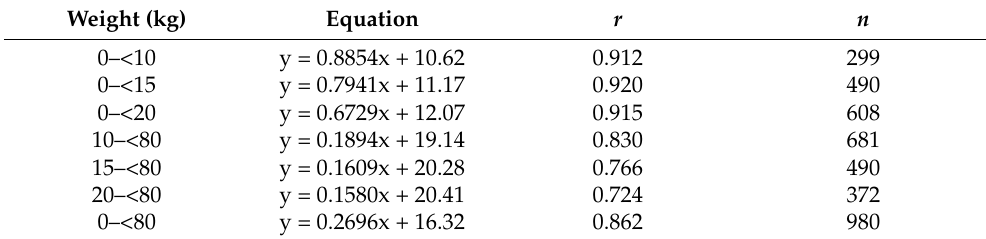
Figure 3. Linear regression analysis of CTDIvol and weight for < 20 kg ( a ) and ≥ 10 kg ( b ). In panel ( a ), the blue, red, and green plots represent data of 0–<10, 10–<15, and 15–<20 kg, respectively. In panel ( b ), the blue, red, and green plots represent data of 10–<15, 15–<20, and 20–<80 kg, respectively. The blue, red, and green lines are regression lines determined using light/heavy cutoffs of 10, 15, and 20 kg, respectively. Table 2. Weight ranges and results of linear regression between CTDIvol and weight.